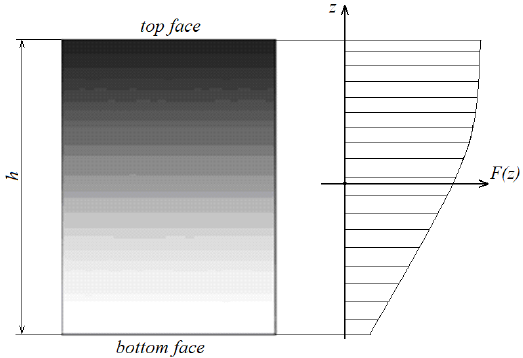
Figure 2. The variation of the properties on the thickness of the material .